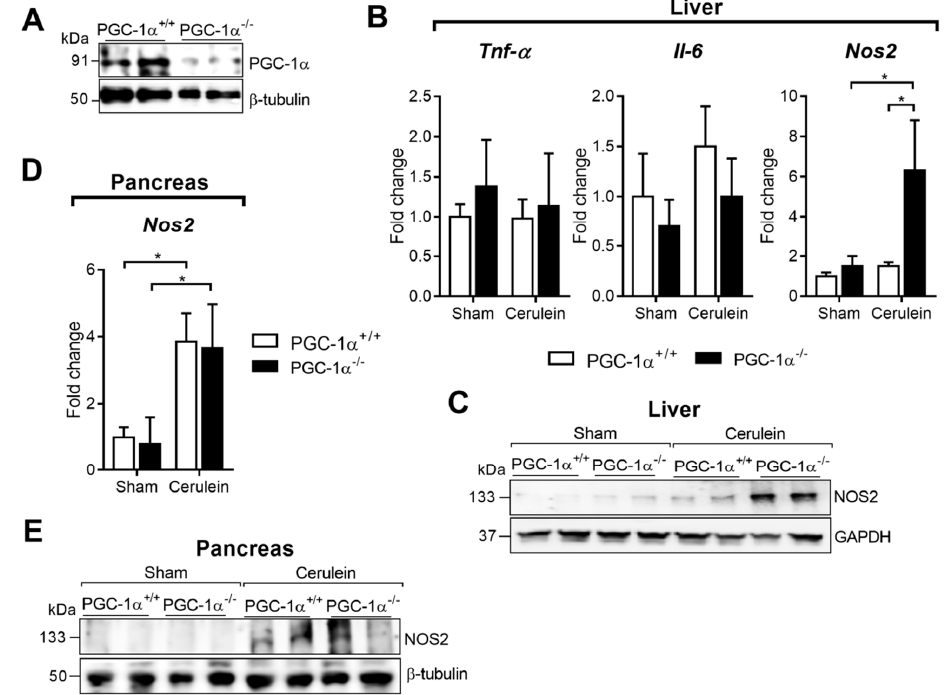
Figure 2. ( A ) Representative Western blot of PGC-1 α in the livers of PGC-1 α +/+ (WT—wild-type) and PGC-1 α -/- (KO—knockout) mice. Β -tubulin was used as the loading control. ( B ) mRNA relative expression of Tnfa , Il6 and Nos2 versus Tbp (TATA binding protein; housekeeping) in the livers of the sham PGC-1 α +/+ (WT) and PGC-1 α -/- (KO) mice and at 1 h after cerulein-induced acute pancreatitis (AP) (Cerulein). ( C ) Representative Western blot of NOS2 in the livers of the sham PGC-1 α +/+ (WT) and PGC-1 α -/- (KO) mice and at 1 h after cerulein-induced AP (Cerulein). GAPDH was used as the loading control. ( D ) mRNA relative levels of Nos2 versus Tbp in the pancreas of the sham PGC-1 α +/+ (WT) and PGC-1 α -/- (KO) mice and at 1 h after cerulein-induced AP (Cerulein). ( E ) Representative Western blot of NOS2 in the pancreas of the sham PGC-1 α +/+ (WT) and PGC-1 α -/- (KO) mice and at 1 h after cerulein-induced AP (Cerulein). Β -tubulin was used as the loading control. There were six mice per group. Statistical difference is indicated as p * < 0.05 vs. Sham.